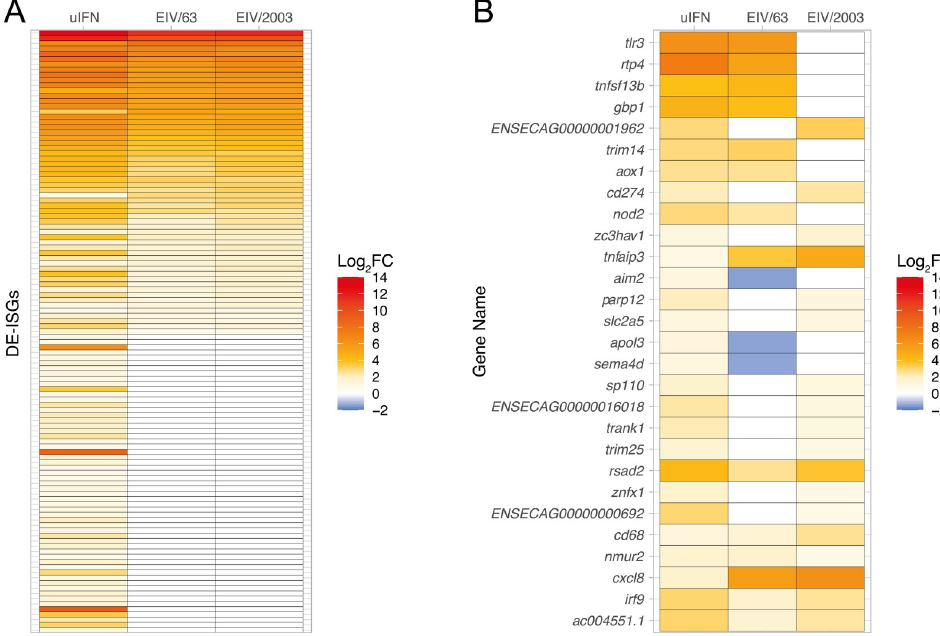
Fig 4. Similarities and differences of ISG regulation induced by EIV/63 or EIV/2003 infections in E.Derm cells. (A) Common differentially expressed interferon-stimulated genes (DE-ISGs) in E.Derm cells treated with universal type I IFN or infected with EIV/63 or EIV/2003 24 hpi. (B) DE-ISGs with significantly different levels of transcription between EIV/63 and EIV/2003 at 24 hpi. Gene expression levels are shown using a blue-white-red colour scale where blue to white indicates downregulation and white to red indicates upregulation. Data represents three independent